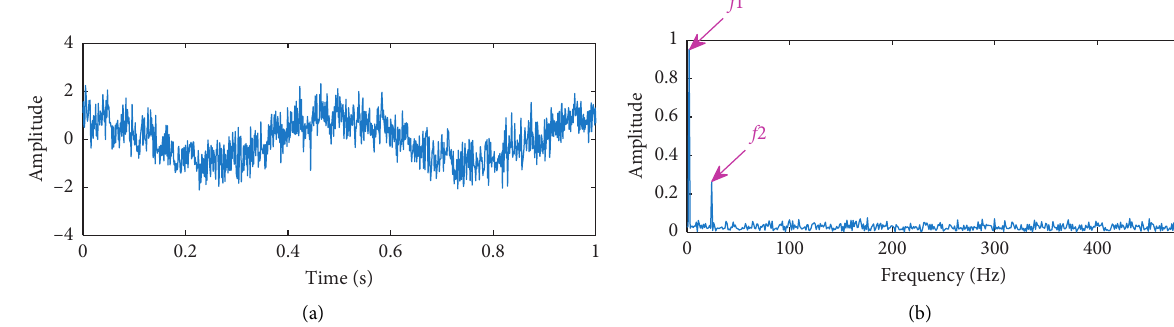
Figure 2: Simulation signal (y): (a) time-domain waveform and (b) frequency spectrum.